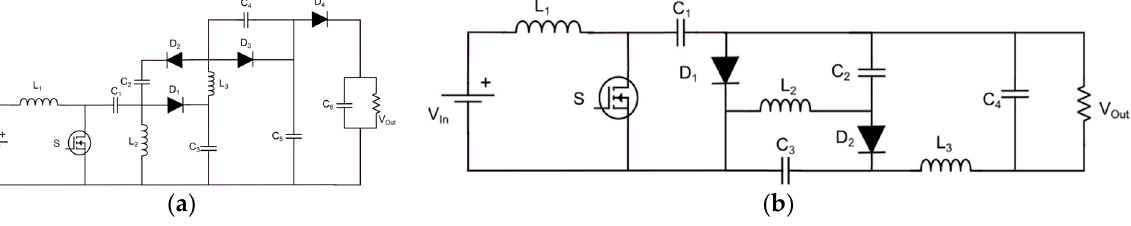
Figure 6. Single-switch boost-buck converter (SSBb) ( a ). Ć uk-based single-switch buck-boost converter (CBSS) ( b